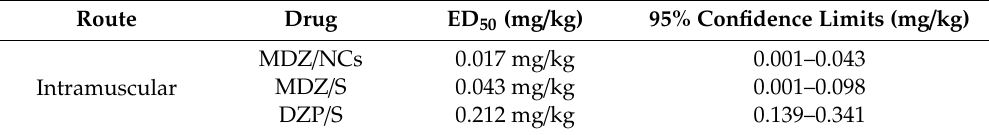
Table 6. ED 50 and 95% confidence limits for the anticonvulsant dose–e ff ect curves for MDZ given by the di ff erent routes of administration at the two treatment times after MST convulsion onset.